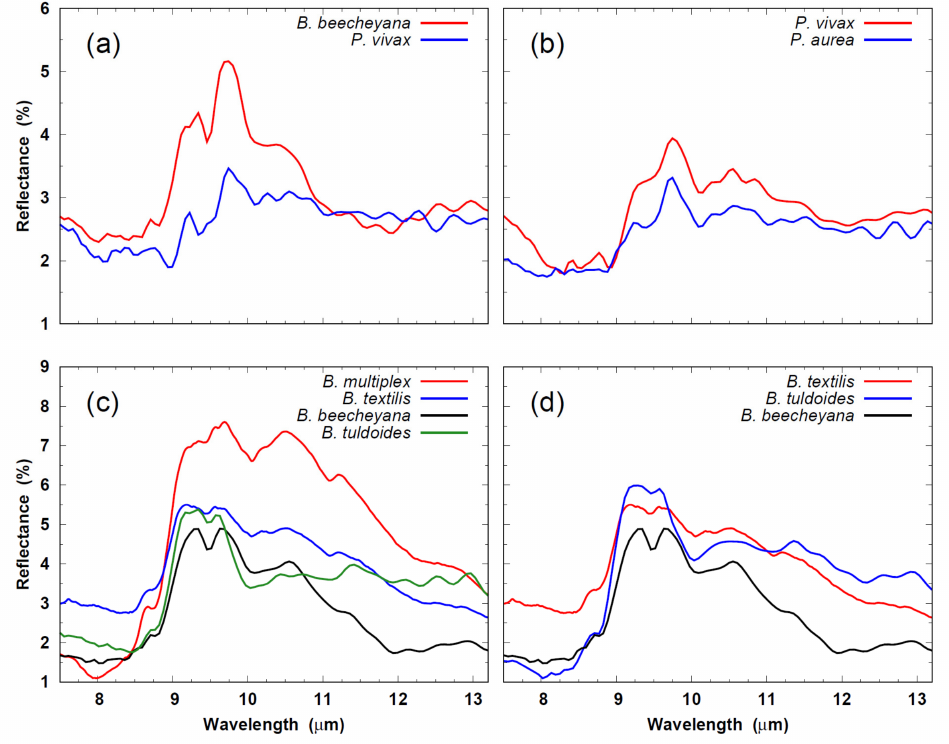
Figure 21. Intercomparison of ID spectra corresponding to the observations in Figure 20: ( a ) stand 1 ( Phyllostachys vivax ), ( b ) stand 2 ( P. aurea ), ( c ) stand 3 ( Bambusa tuldoides ), ( d ) stand 4 ( B. textilis